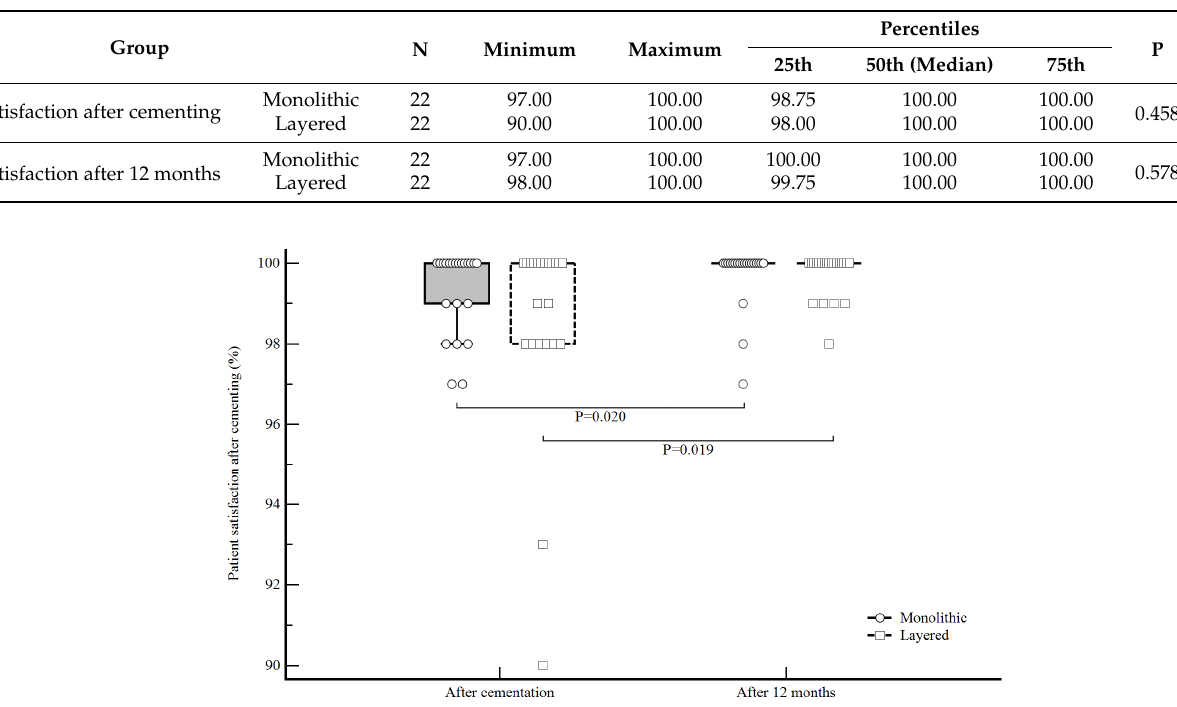
Figure 1. Differences in patients’ aesthetic satisfaction score before and after 12 months for each group: Wilcoxon test.